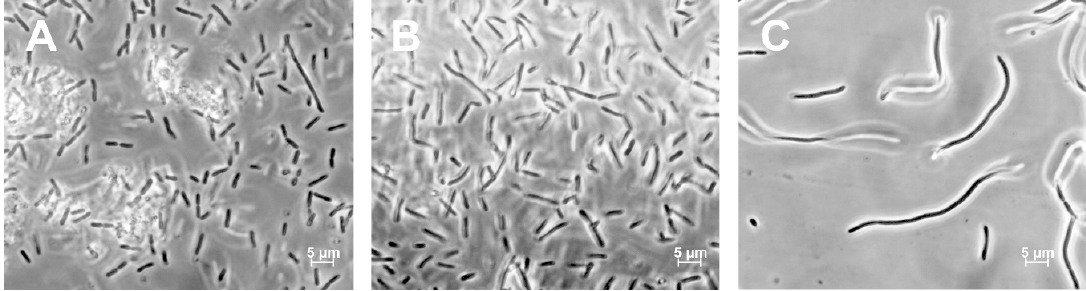
Figure 8. The wild-type and mutant phenotypes of Synechococcus . ( A ) Mutant Δ NR385. ( B ) The wild type of Synechococcus . C. Mutant Δ NR401.